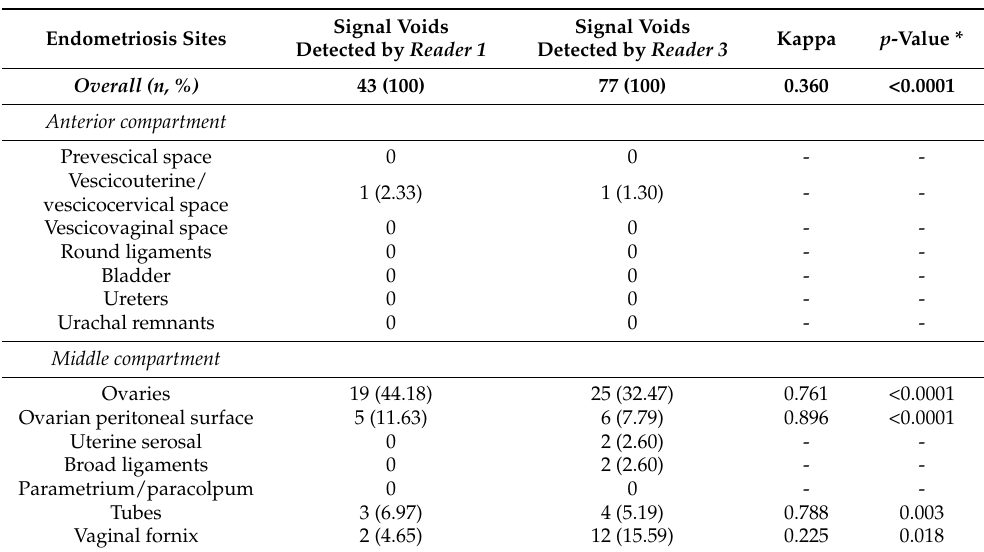
Table 5. Comparison between regions described as positive for signal voids on T2*-weighted se- quences by Readers 1 and